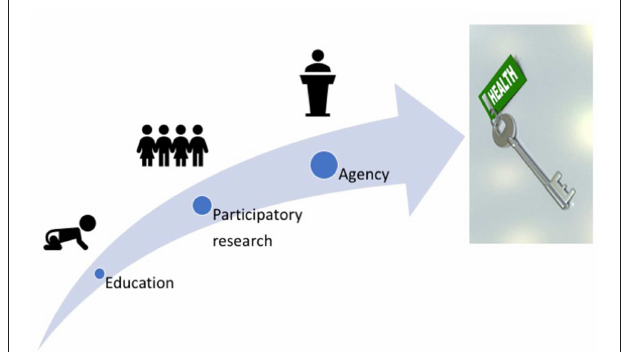
FIGURE 1 | The future management of well-being. An effective system of management of well-being that can be applied to all human beings should be based on an effective system of education that empowers people to distinguish the good from the bad. Participatory research between the lay public and researchers in all fields of science should address health problems that are concerns for the whole society. Finally, the results of these studies should allow individuals to make conscious and independent choices of what needs to be done to keep a state of health and well-being that is unique as we all